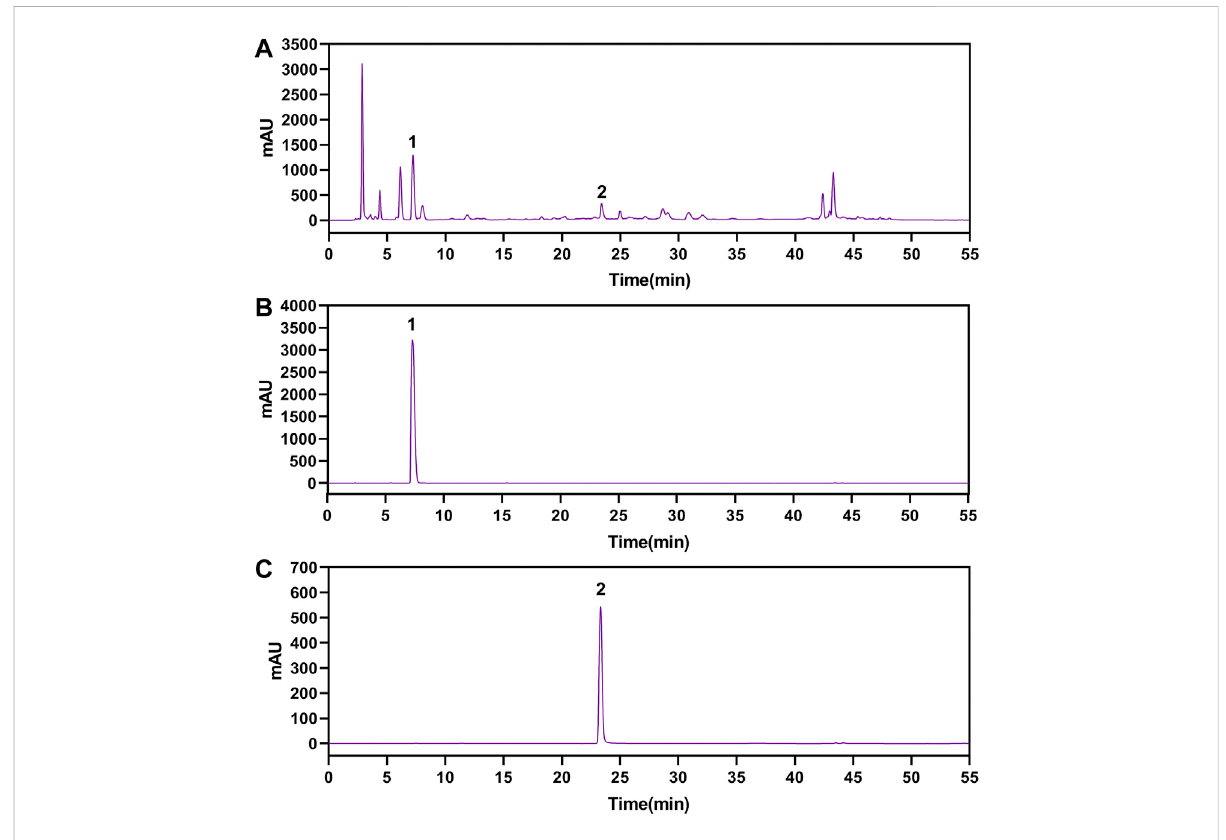
FIGURE 2 The HPLC chromatograms of LWPE (A) , gallic acid (B) and methyl gallate (C)